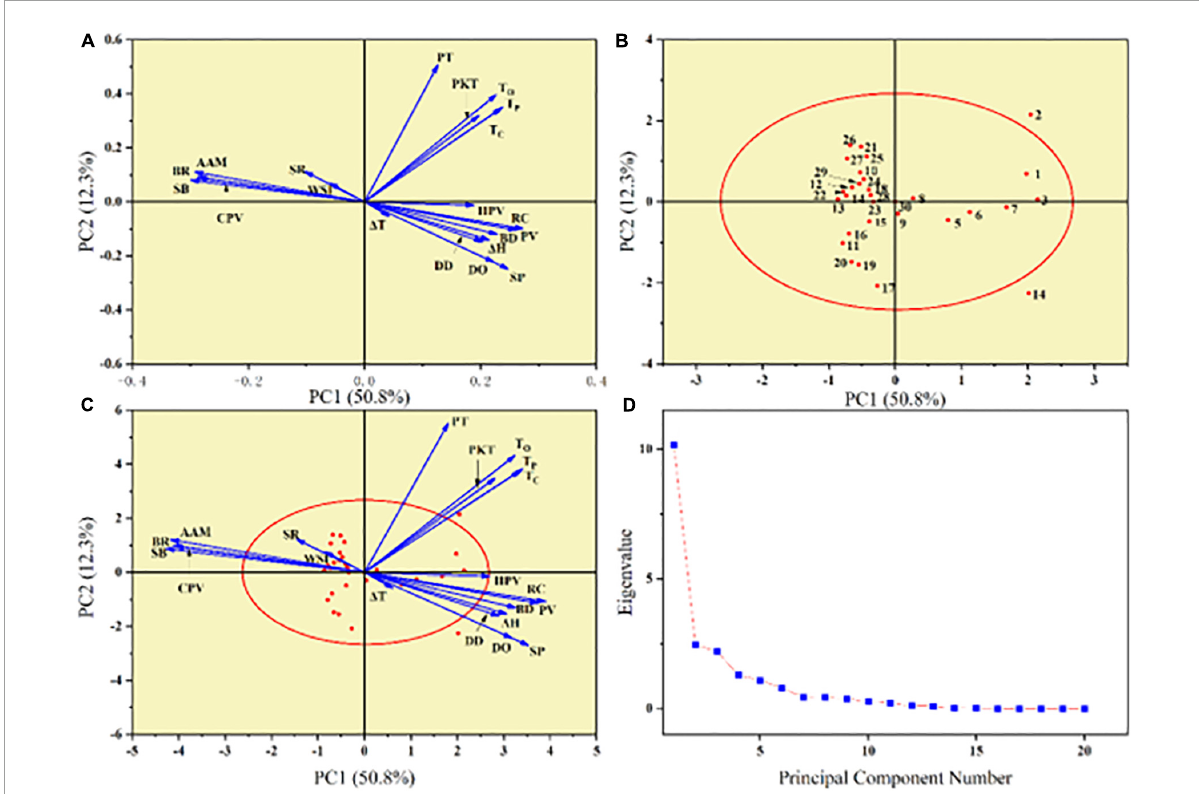
FIGURE7 Principle component analysis (PCA) describing the variations in physicochemical properties of sorghum starch. (A) Loading plot of PC1-PC2. (B) Score plot of PC1-PC2. (C) Combination of loading and score plots of PC1-PC2. (D) Scree plot for 30 sorghum starch